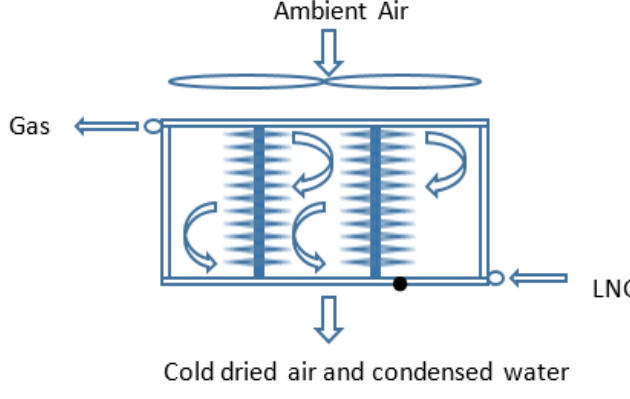
Figure 3. Ambient air vaporizer.